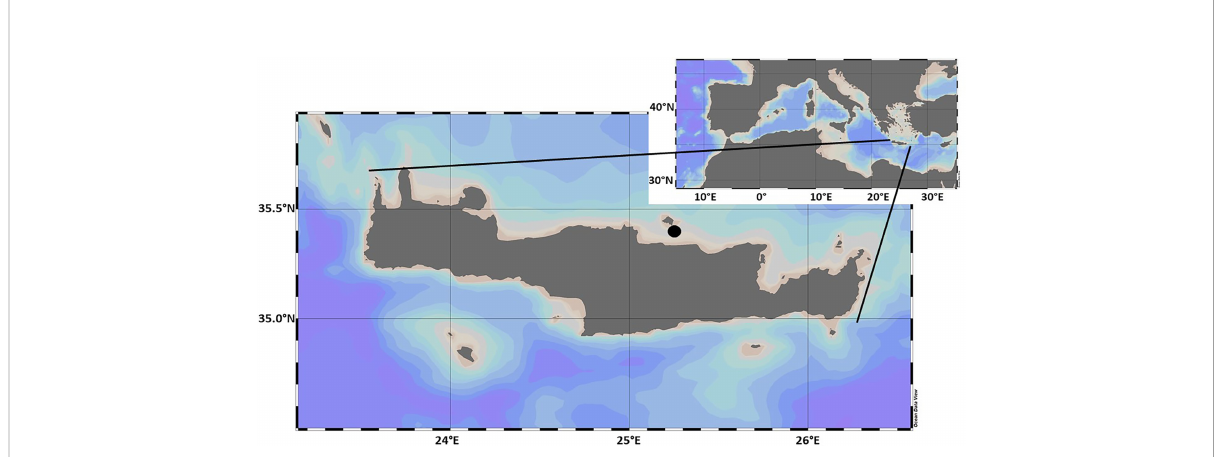
FIGURE 1 Study area showing the position of Crete in the Mediterranean Sea, and the sampling location (Filled black circle) where seawater was collected for the purpose of the SiNAME experiment (Bay of Gournes). Map created using Ocean Data